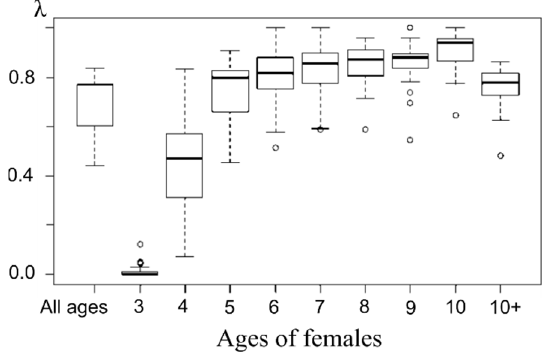
Figure 10. Box plot of pregnant females’ proportion of each age from marine